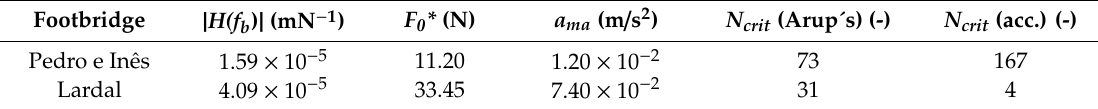
Table 4. Numerical response simulation. Results obtained by applying Hivoss guideline.